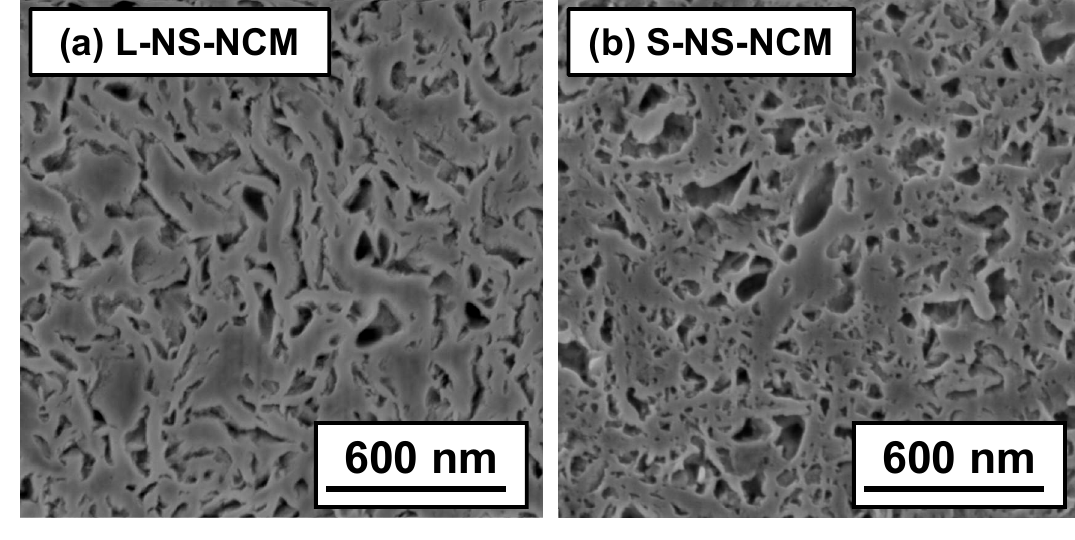
Figure 4. Cross-sectional SEM images of ( a ) L-NS-NCM and ( b )